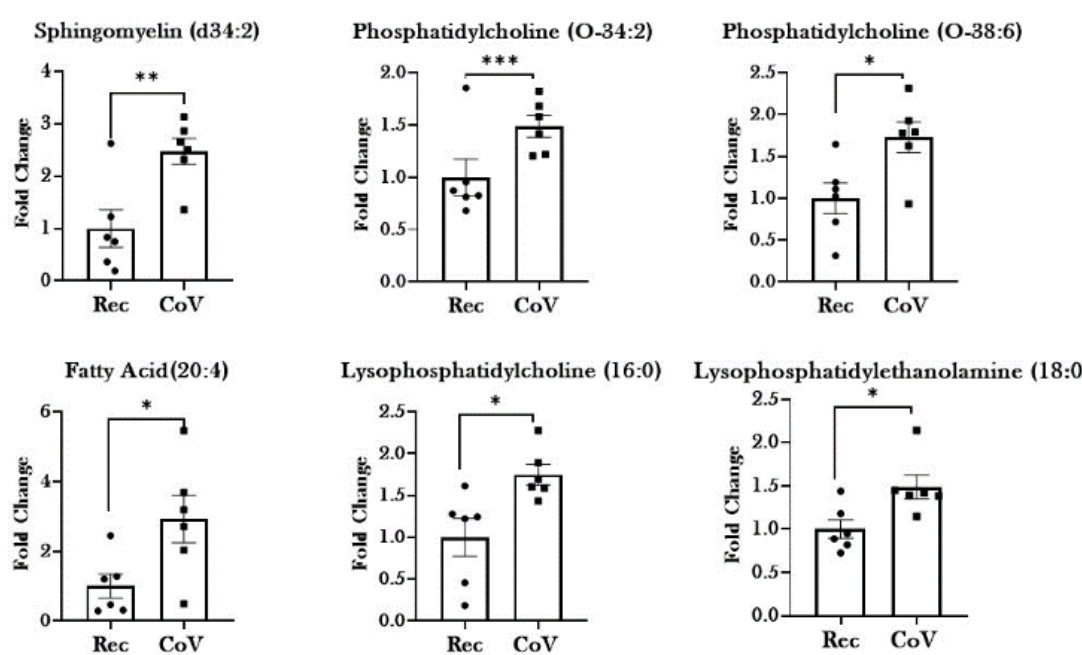
Figure 5. Dysregulation of lipid metabolism in patients with COVID-19. Metabolomic analyses of serum samples from COVID-19-positive (CoV) and COVID-19-recovered (Rec) patients were performed using UPLC-MS. Fold changes in the levels of serum lipids and their metabolites in CoV and Rec samples were plotted as a bar graph. Data are shown as mean ± SEM ( n = 6/group). * p < 0.05, ** p < 0.01, *** p < 0.001 vs. Rec as per unpaired t -test. Table 1. Significantly altered metabolites in the serum of COVID-19-positive patients with observed fold changes.